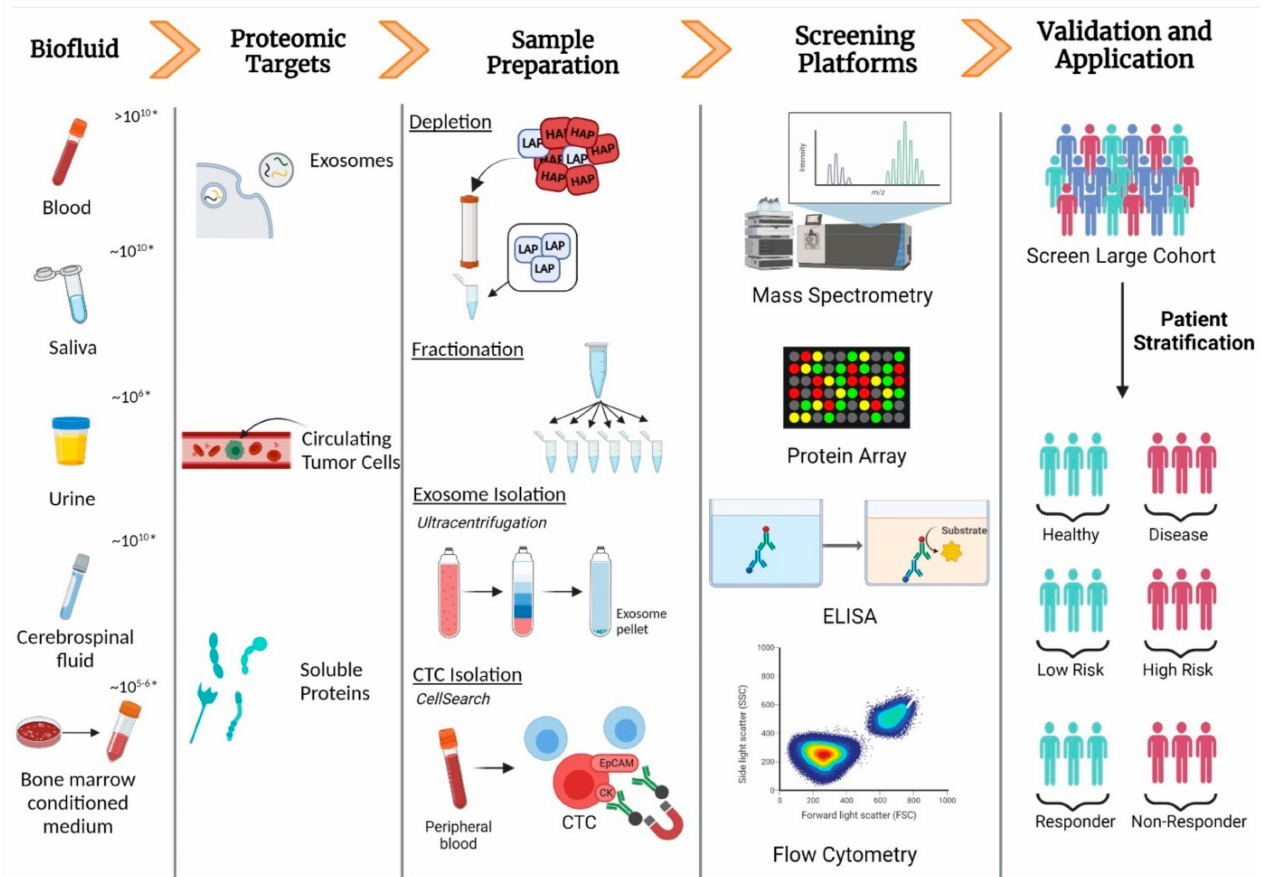
Figure 2. Schematic illustrating the steps involved in the detection of protein biomarkers in biofluids and their applications in a clinical setting. HAP, high-abundance protein; LAP, low-abundance protein; CTC, circulating tumour cell; ELISA, enzyme-linked immunosorbent assay; EpCAM, epithelial cell adhesion molecule; CK, cytokeratin. * Dynamic range of corresponding biofluid. Created using